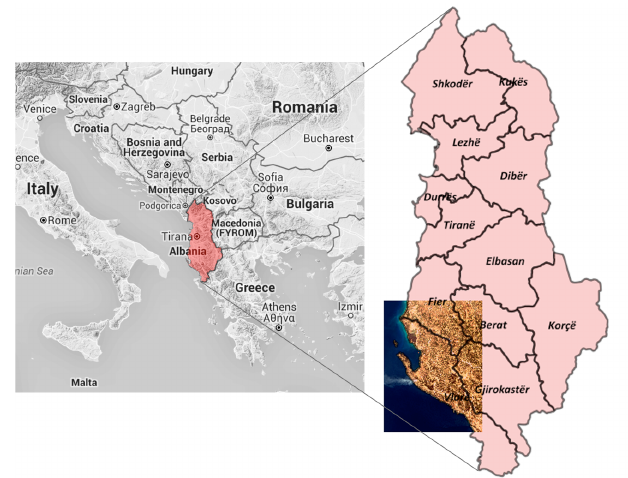
Figure 1. Location map of the study